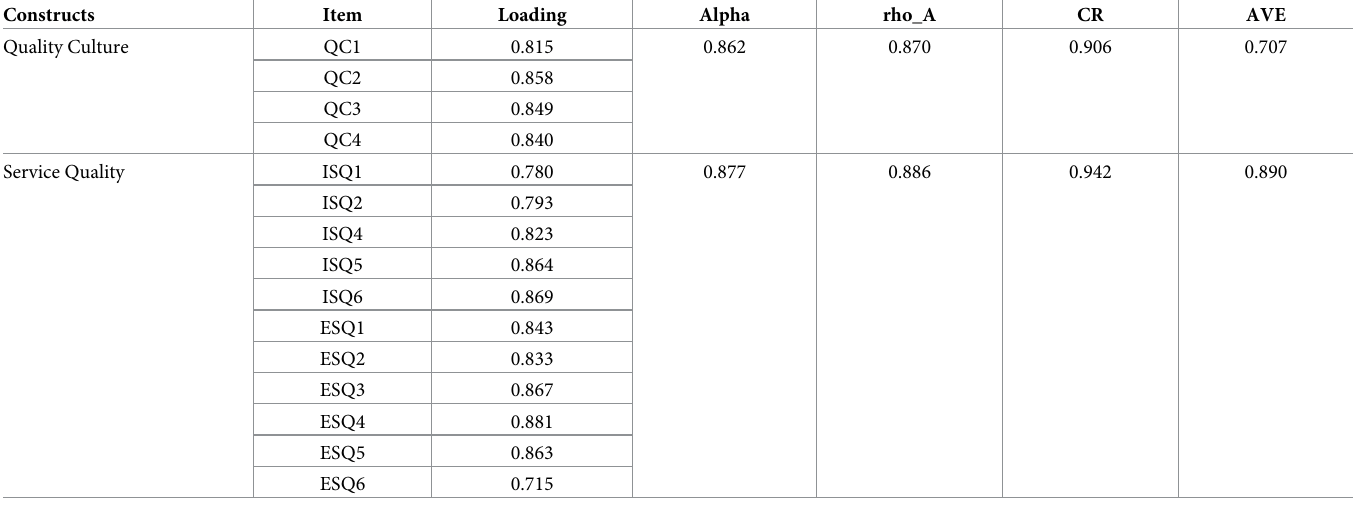
Table 3. Factor loading, reliability, and convergent validity.